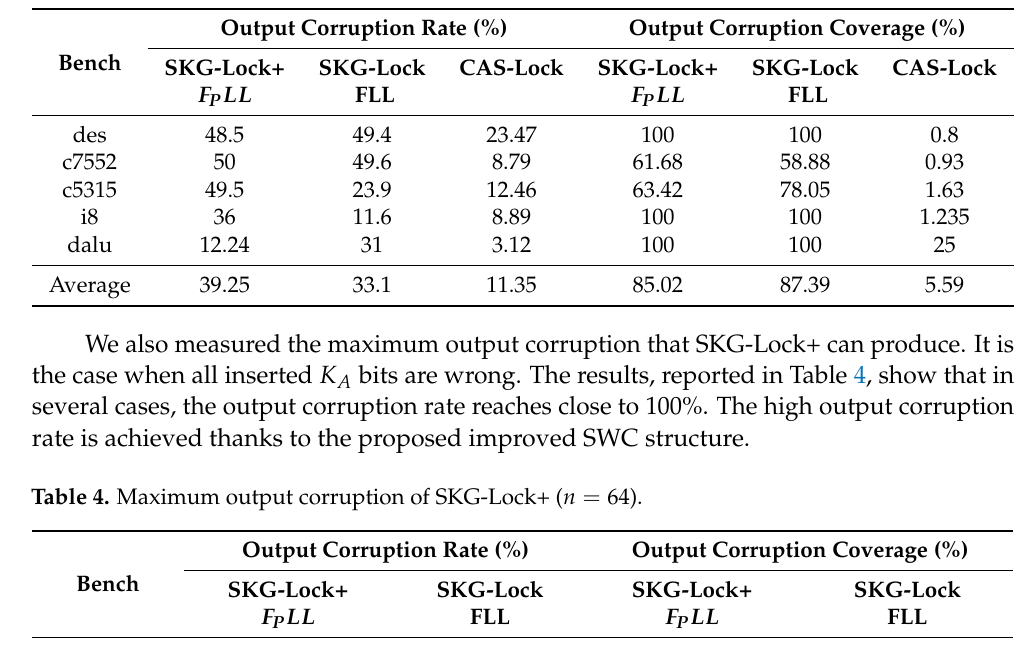
Table 3. Output corruption evaluation on SKG-Lock+ ( n = 64).